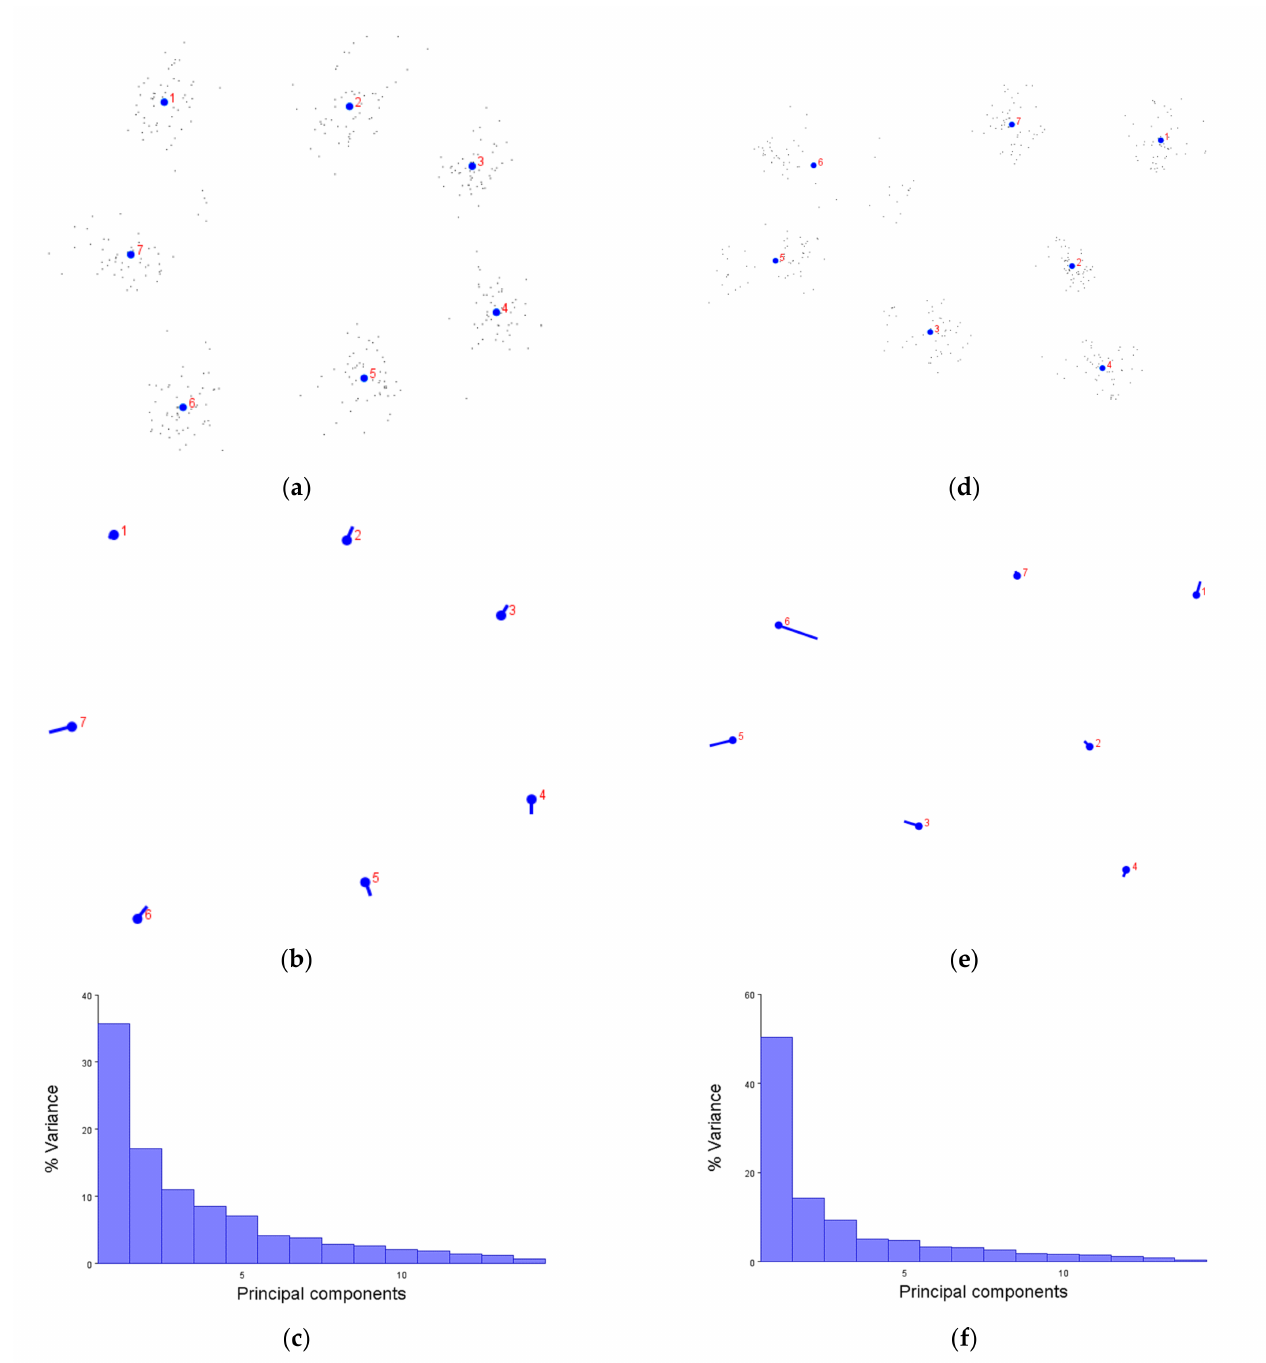
Figure A2. Supplementary graphs to support Figure 4. ( a ) Generalised Procrustese transformation, ( b ) PC1 variation and ( c ) eigenvalues for the extracellular face of the family B receptors. ( d ) Generalised Procrustese transformation, ( e ) PC1 variation and ( f ) eigenvalues for the intracellular face of the family B